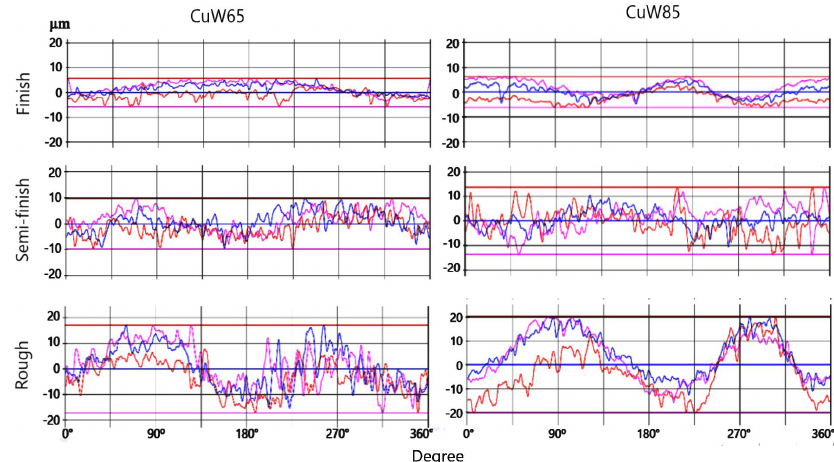
Figure 3. Circularity deviations for rough, semifinish and finish ED-Machining with both CuW electrode